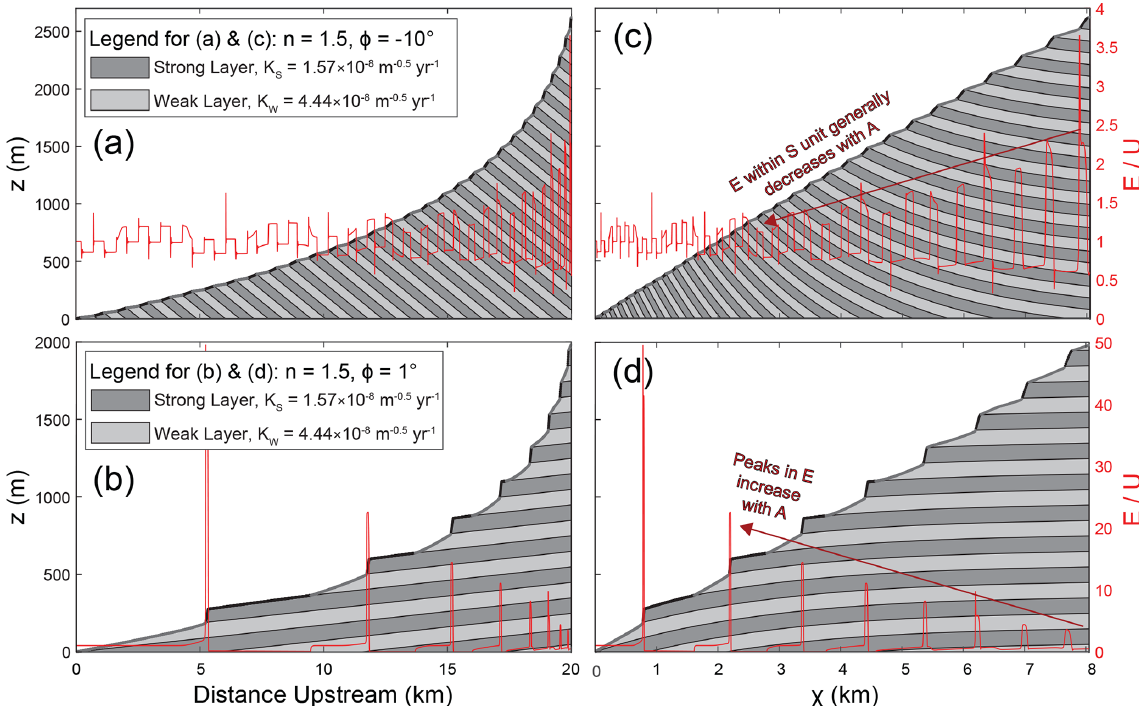
Figure 8. Longitudinal profiles (a, b) and χ plots (c, d) for two different simulations with n = 1 . 5. The simulation in (a) and (c) has contact dip φ = − 10 ◦ , while the simulation in (b) and (d) has φ = 1 ◦ . Layer thickness H and rock-uplift rate U are 100 m and 0.15mmyr − 1 in both simulations,